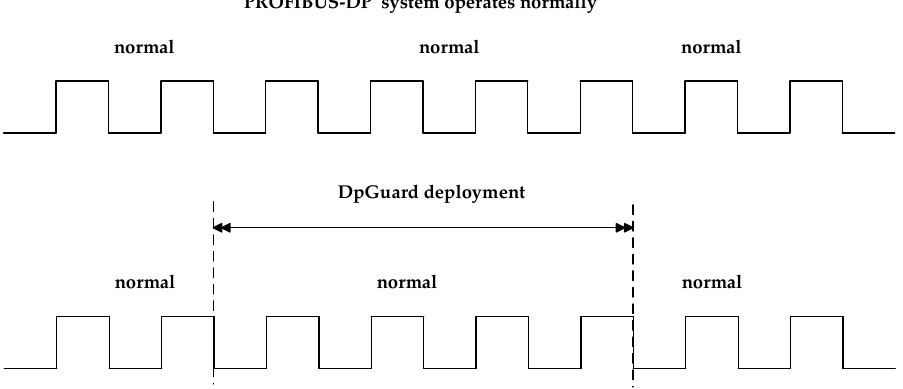
Figure 7. Comparison of PROFIBUS-DP system waveforms before and after DpGuard deployment.